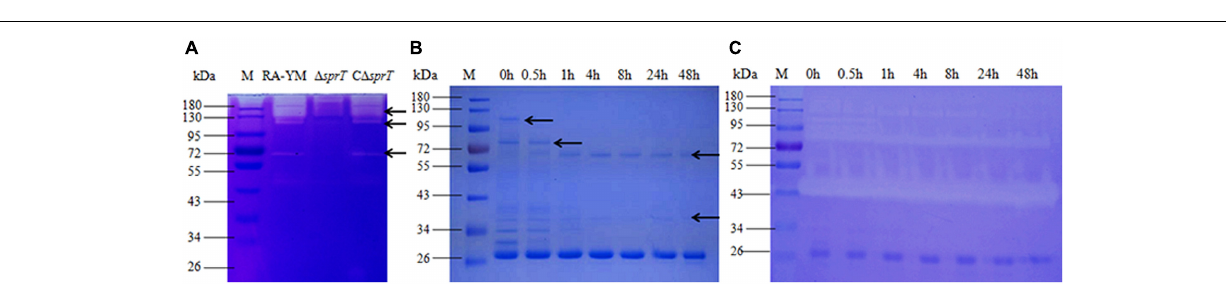
FIGURE 3 | (A) Gelatin zymography assay of wild-type strain RA-YM, mutant strain (cid:49) sprT, and complemented strain C (cid:49) sprT . Regions of clearing reflect protease activity. Black arrows indicate distinct protease activity present in RA-YM and (cid:49) sprT . These bands were excised for identification by MS. (B) SDS-PAGE analysis of recombinant RAYM_01812 protein incubated at 37 ◦ C for different times. M: protein marker; lane 1: purified GST-RAYM_01812 fusion protein; lanes 2–7: purified GST-RAYM_01812 fusion protein incubated at 37 ◦ C for 0.5 h (lane 2), 1 h (lane 3), 4 h (lane 4), 8 h (lane 5), 24 h (lane 6), and 48 h (lane 7). (C) Ability of purified RAYM_01812 protein to degrade gelatin after incubation at 37 ◦ C for different times. M: protein marker; lane 1: purified GST-RAYM_01812 fusion protein; lanes 2–7: gelatin zymography analysis of GST-01812 fusion protein incubated at 37 ◦ C for 0.5 h (lane 2), 1 h (lane 3), 4 h (lane 4), 8 h (lane 5), 24 h (lane 6), and 48 h (lane